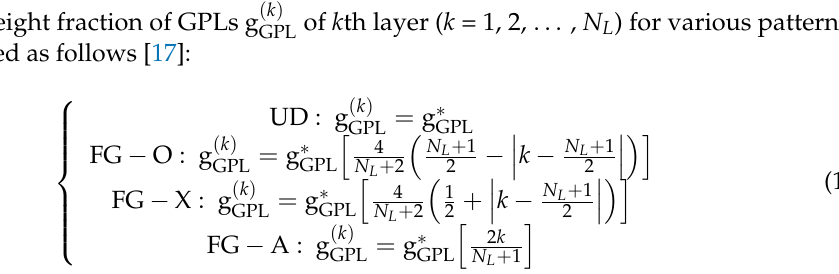
Figure 1. Geometry and cross-sections of FG-GRC laminated nanoplate. ( a ) plate geometry ( b ) gradation types ( c ) layer’s order